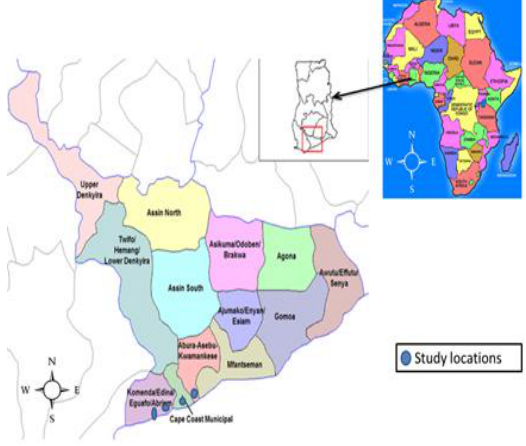
Fig. 3: Map of Africa, indicating study communities in